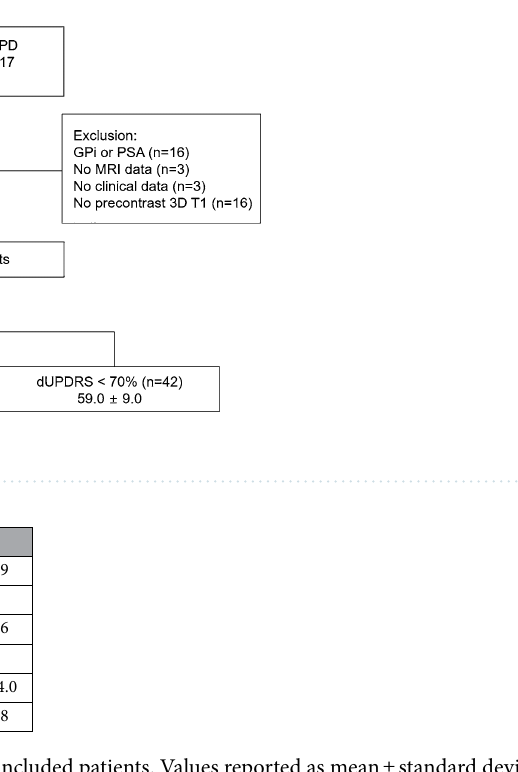
Table 1. Demographic data of the included patients. Values reported as mean ± standard